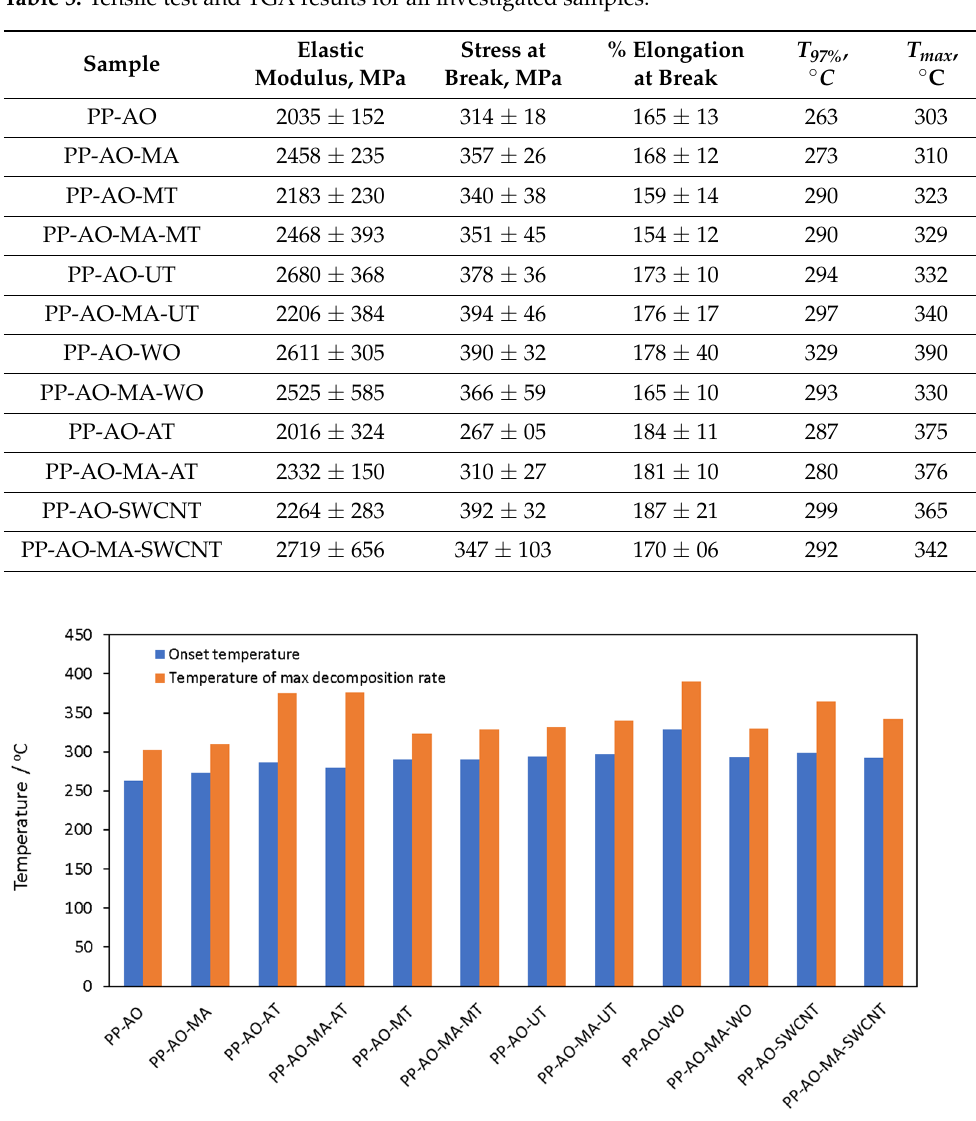
Table 5. Tensile test and TGA results for all investigated samples.